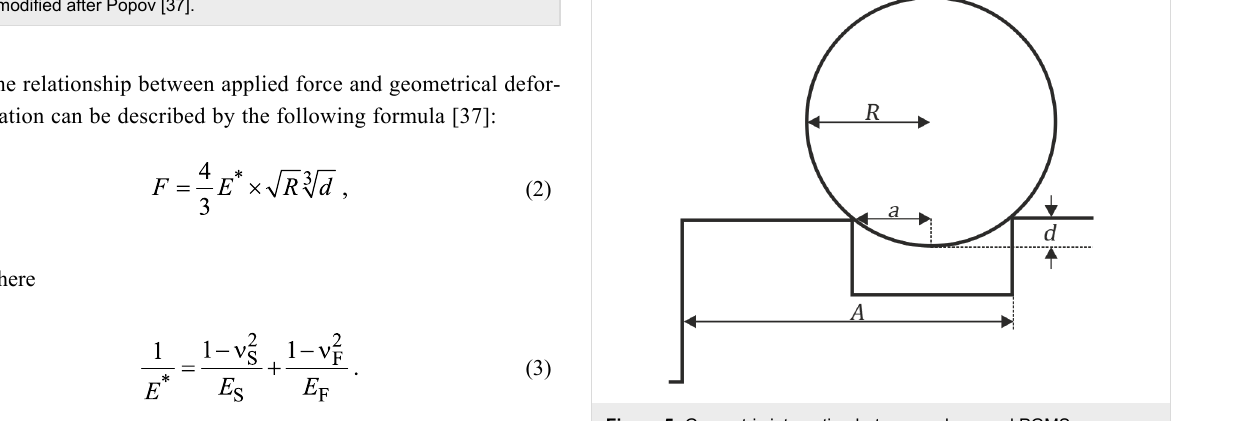
Figure 5: Geometric interaction between sphere and PGMS. R : sphere radius. a : indentation radius. d : indentation depth. The elastic response of the materials is excluded. Image modified after Sondhauß et al.